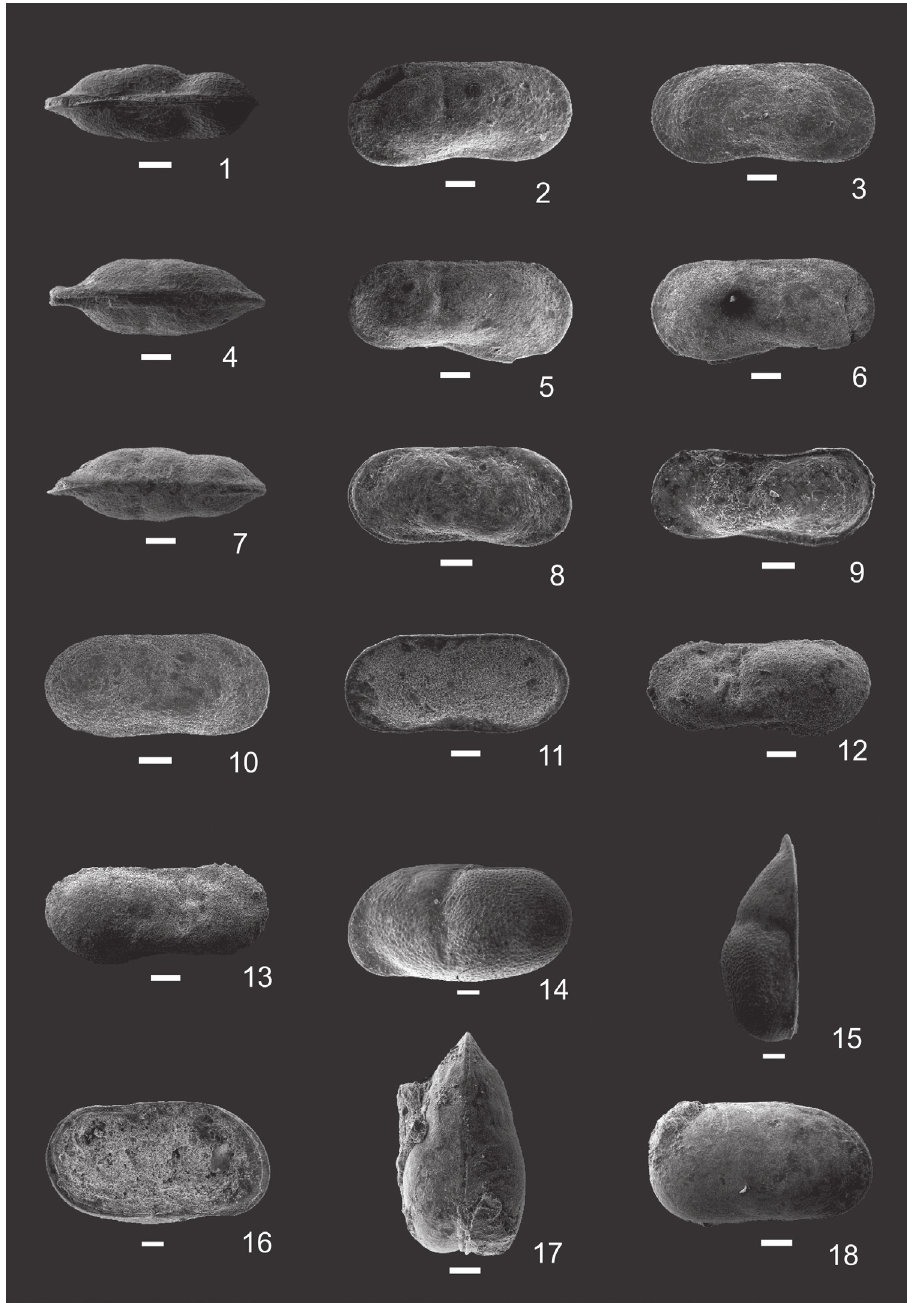
Figure 5 - 1 Limnocythere mandubi sp. nov. (ULVG 11519, C), ventral view; 2-9 Limnocythere katu sp. nov., 2. Left lateral view (ULVG 11522, female C); 3. Right lateral view; 4. Dorsal view; 5. Left lateral view (ULVG 11523, male C); 6. Right lateral view; 7. Dorsal view; 8. Right lateral view (ULVG 11524, A-1 C); 9. Internal view (ULVG 11535, male A-1 RV); 10-11 Limnocythere sp. 1 (ULVG 11525, RV), 10. External view; 11. Internal view. 12-13 Limnocythere ? sp. (ULVG 11526, CC), 12. Left lateral view; 13. Right lateral view; 14-16 Cytheridella sp. 1 (ULVG 11527, LV), 14. External view; 15. Dorsal view; 16. Internal view. 17-18 Cytheridella sp. 2 (ULVG 11528, C), 17. Dorsal view; 18. Right lateral view.